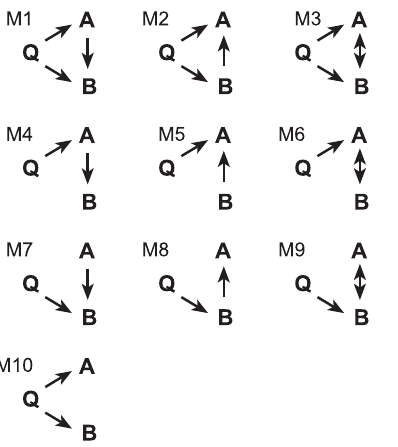
Figure 1. Causal Relationships among a QTL and Two Phenotypes Single-headed arrows indicate causal effects and doubled-headed arrows indicate unresolved associations between the two phenotypes. Pheno- types are indicated by A and B; QTL by Q. DOI: